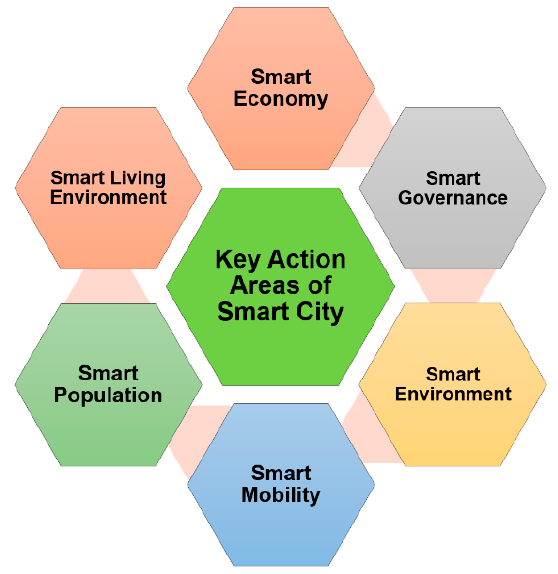
Figure 1. Key Action Areas of a Smart City.